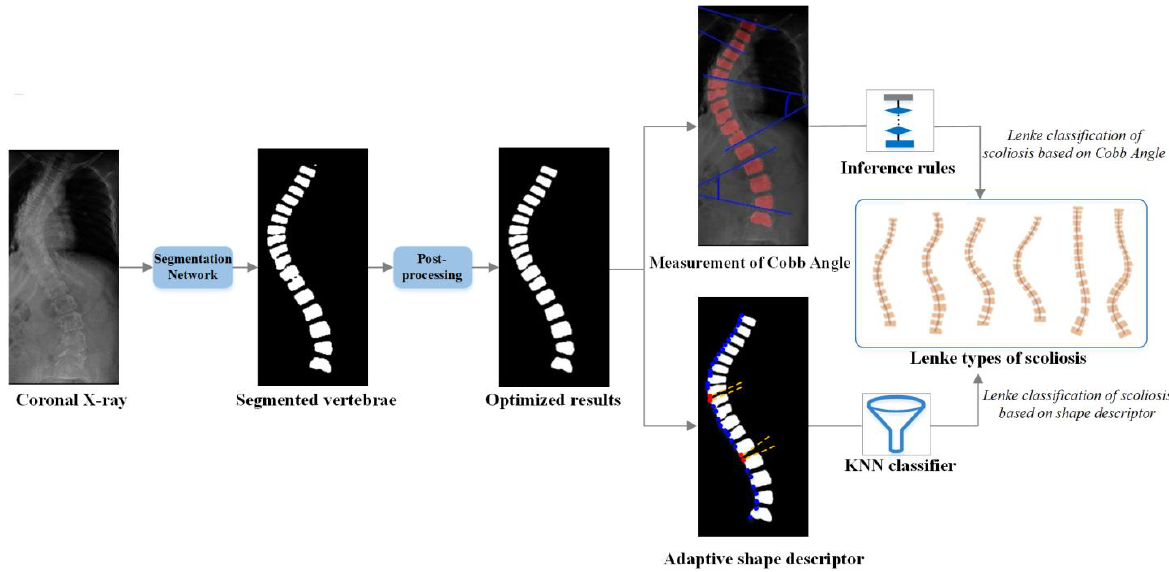
Figure 2. An overview of the proposed